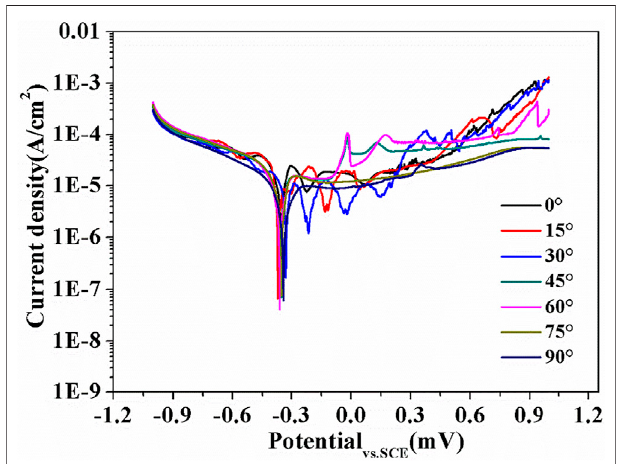
FIGURE 10 | Potentiodynamic polarization curves of SLM-processed 316L SS from different angles relative tothebuild substrate ina3.5 wt%NaCl solution.